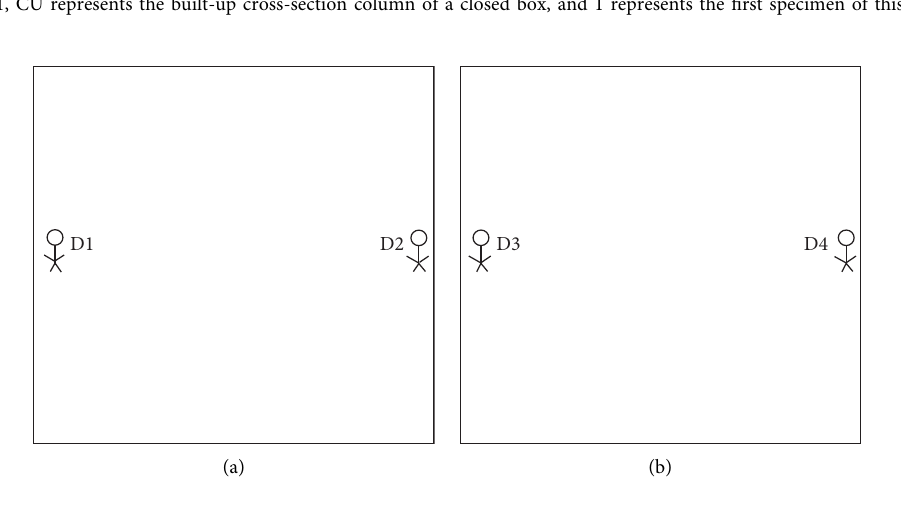
Figure 1: Diagram of the displacement gauges: (a) lower part of the upper end plate and (b) upper part of the lower end plate.